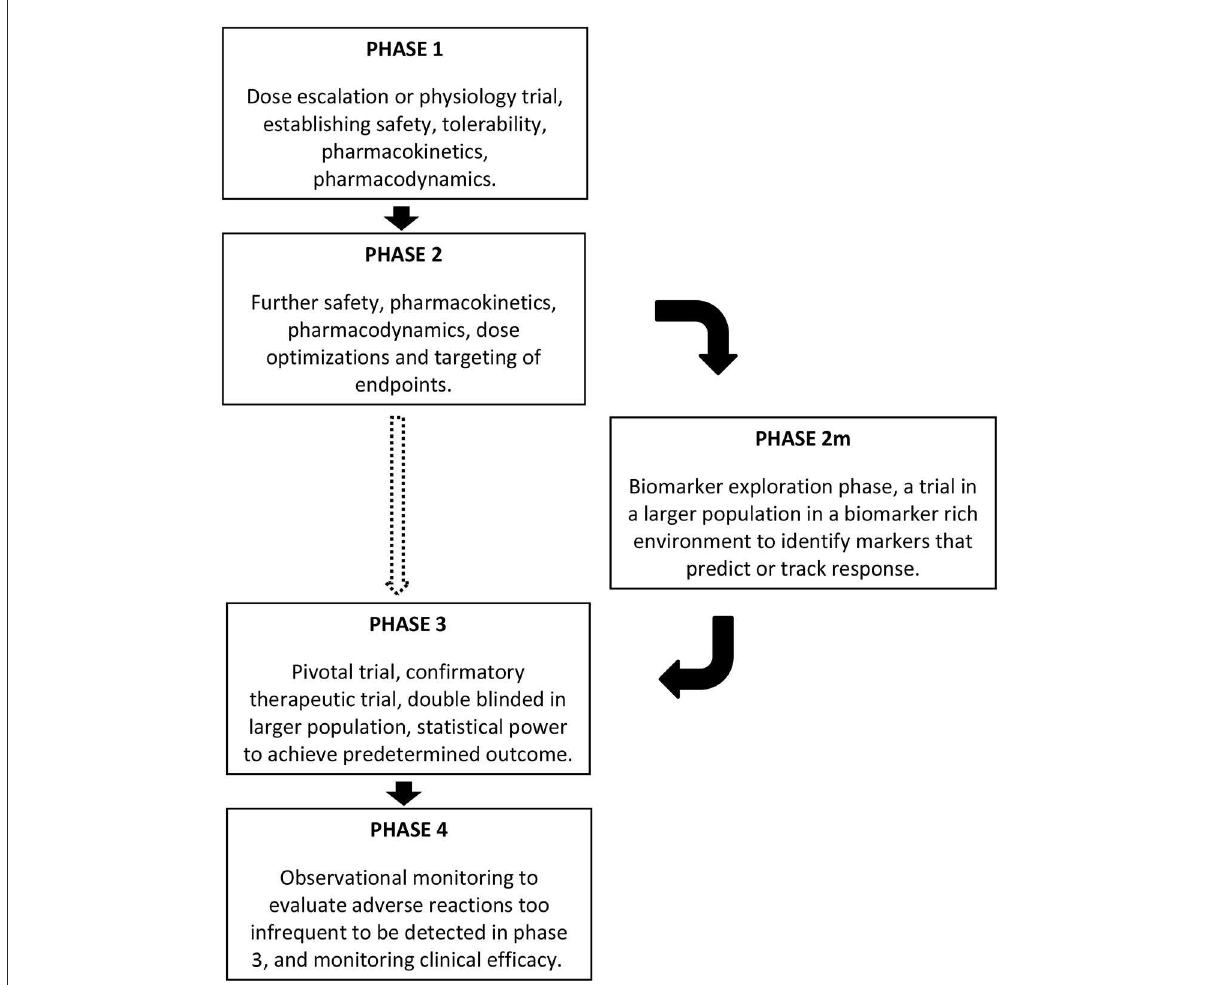
FIGURE1 Schematic representing the location of a phase 2m in clinical trials, after phase 1 and phase 2, and before phase 3, if the need for a biomarker exploration phase is warranted based on the nature of the clinical condition. The dashed arrow moving directly from phase 2 to phase 3 might be appropriate for some conditions, but incorporating the phase 2m seems warranted in conditions such as